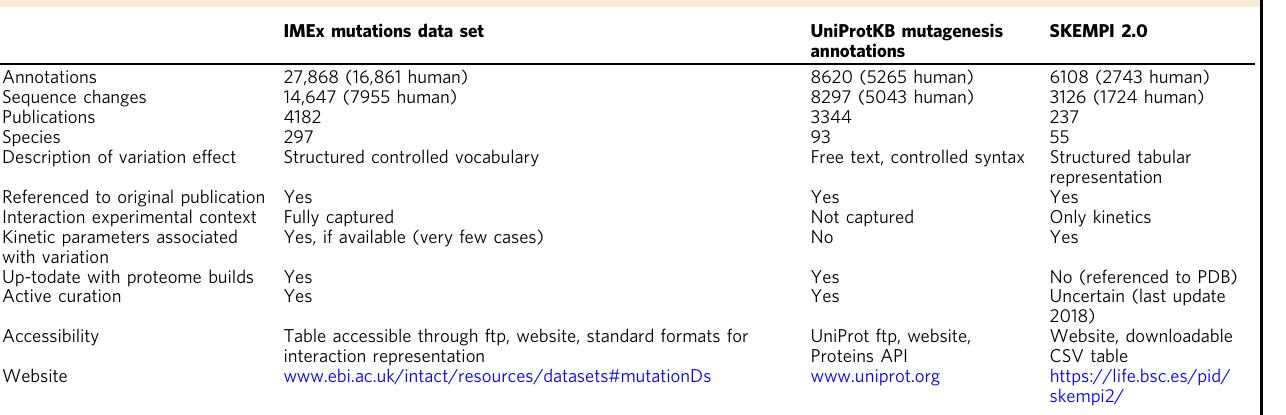
Table accessible through ftp, website, standard formats for interaction